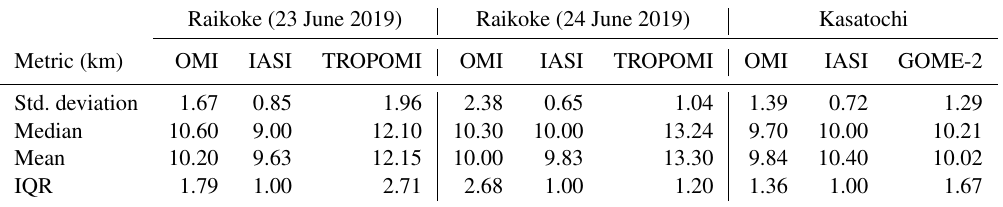
Figure 6. Comparison between the volcanic plume heights from (a) OMI, (b) IASI, (c) GOME-2, and (d) CALIOP lidar 532nm attenuated backscatter for the 2008 Kasatochi eruption. The black dotted line in (a) shows the CALIPSO track. Some rows of OMI in this case were affected by the row anomaly, as seen by the gaps in the plume. The red dots in (d) show the OMI retrieval near the CALIPSO path, and the black dashed line denotes the height of the ash plume observed by CALIPSO. Table 4. Statistical comparisons of the SO 2 height retrievals for 2d of the Raikoke eruption and the Kasatochi eruption